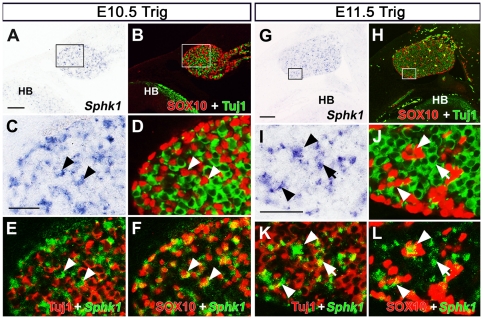

Sphk1 expression in the developing trigeminal ganglion.
Sphk1 transcript was detected by section in situ hybridization followed by Tuj1 and SOX10, immunostaining. (A–F) Sphk1 expression in E10.5 (32–35 somites) trigeminal ganglion. (A) Sphk1 mRNA (purple) can be observed in the trigeminal ganglion and hindbrain (HB). (B) The same section in (A) was processed for Tuj-1 (green) and SOX10 (red) immunostaining. (C–F) Enlarged image of boxed area in A and B. (C) Sphk1 (purple) is not expressed in all cells in the trigeminal ganglion. (D–F) Co-staining with Tuj-1 (green) and SOX10 (red) reveals that Sphk1 can be seen in Sox10+ progenitor cells (arrowhead) but not Tuj1+ neurons at E10.5. (E, F), Sphk1 signal was pseudo-colored as green, Tuj1 and SOX10 immunostaining as red. Sphk1 signals are not found in Tuj-1+ neurons (arrowhead). Sphk1 signal (green) co-localized with SOX10+ cells (arrowhead). (G–L) Sphk1 expression in E11.5 (40–42 somites) trigeminal ganglion. (G) Sphk1
(purple) expression persists in E11.5 trigeminal ganglion. (H) The same section in (G) was processed for Tuj-1 (green) and SOX10 (red) immunostaining. (I–L) Enlarged imaged of boxed area in G and H. (I, J) Sphk1
(purple) is expressed in a subpopulation of cells in the trigeminal ganglion. Sphk1 can be observed in SOX10+ cells (arrowhead). Some neurons (Tuj1+, green) also express Sphk1 at this stage (arrow). (K,L) Sphk1 in situ signal was pseudo-colored green, Tuj1 and SOX10 reactivity as red to observe overlap of in situ and immuostaining signals. Sphk1 mRNA (green) can be detected in some neurons at E11.5 trigeminal ganglion (arrow). A subset of SOX10+ cells express Sphk1
(arrowhead). HB = hindbrain. Scalebar for A, B = 200 µm; scalebar for C–F = 50 µm; scalebar for G, H = 100 µm; scalebar for I–L = 50 µm.